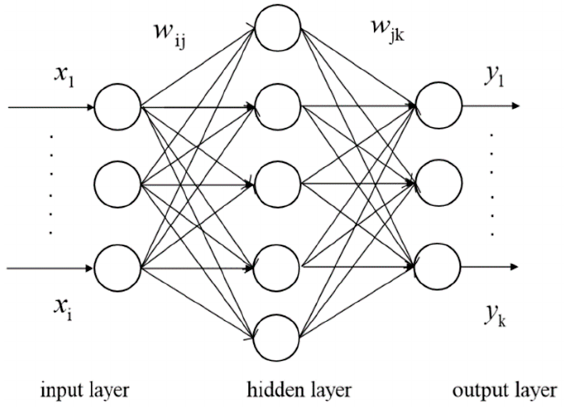
Figure 2. Schematic diagram of the BP neural network structure. ( x i represents input parameters, w ij and w jk represent weights, and y k represents output parameters).